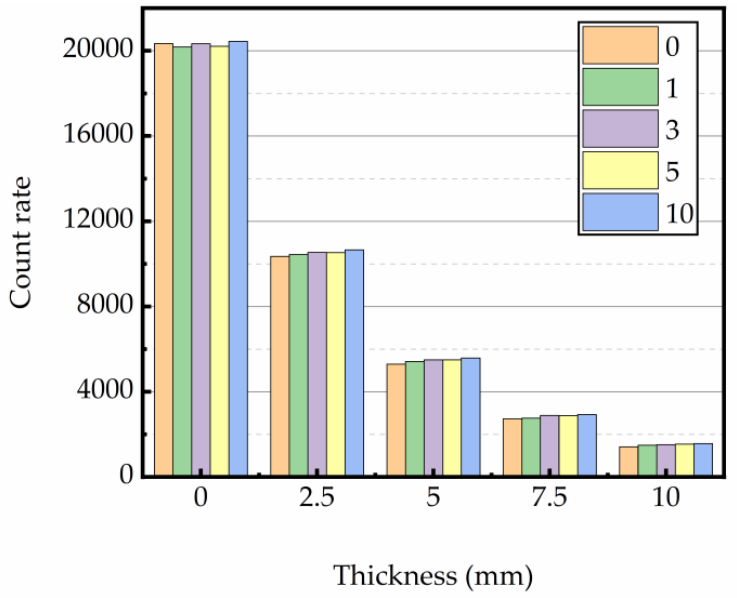
Figure 12. Relationship between thickness and counts at 200 °C.